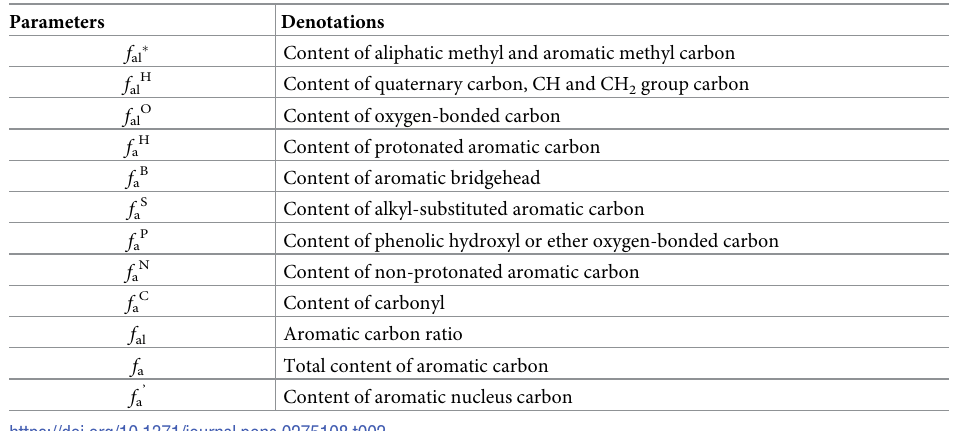
Table 2. Denotations of the coal structure